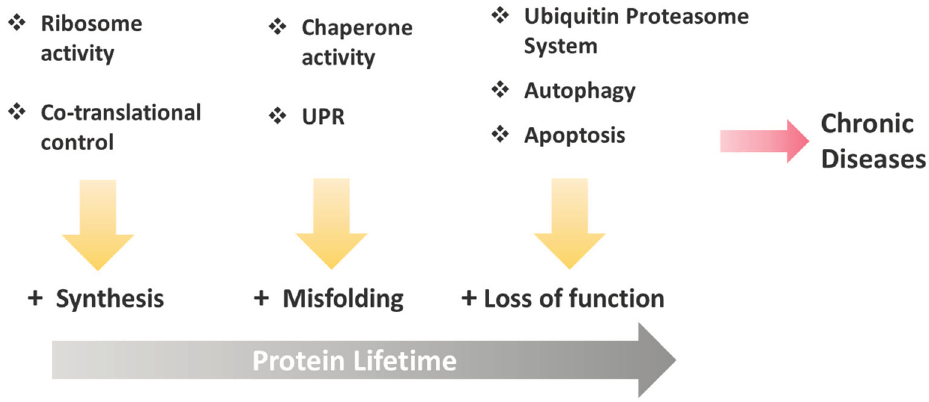
Figure 1. Molecular and cellular mechanisms to maintain native protein structure. The vertical arrows indicate the mechanisms which cells employ to counteract alterations in native protein structure, during their lifetime (horizontal arrow). When the cellular machinery designed to control widespread protein misfolding or aggregation fails, apoptosis ensues. When apoptosis cannot restrict the systemic spread of protein misfolding, chronic diseases originate (red